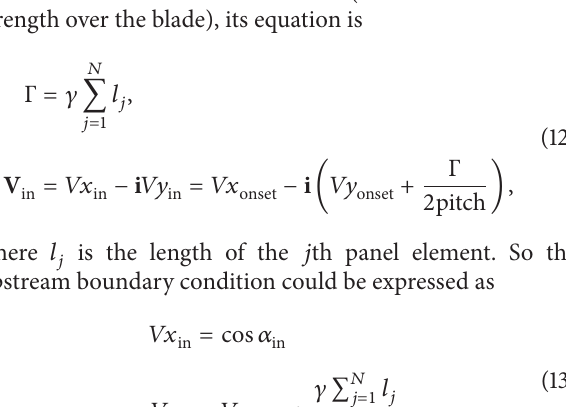
section of that virtual flow path at the same axial location. 𝑀 𝛼 ref and ref are the average flow angle and the average